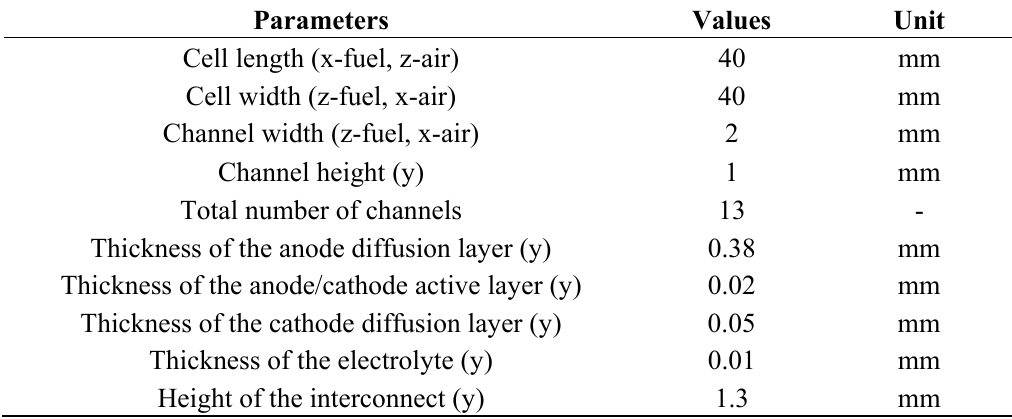
Table 1. Geometrical parameters of simulation